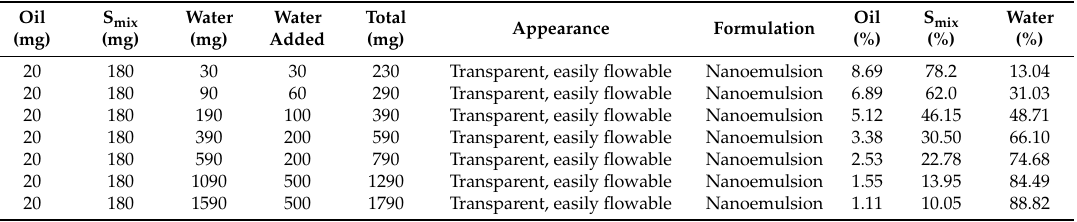
Figure 2. Ternary plots for nanoemulsions obtained using cinnamon oil, tween 80 and Carbitol ® . Table 1. Formulation titration trials conducted for S mix ratio 1:9 (Tween 80:Carbitol ® ) and 5:1 (Cinnamon oil:S mix